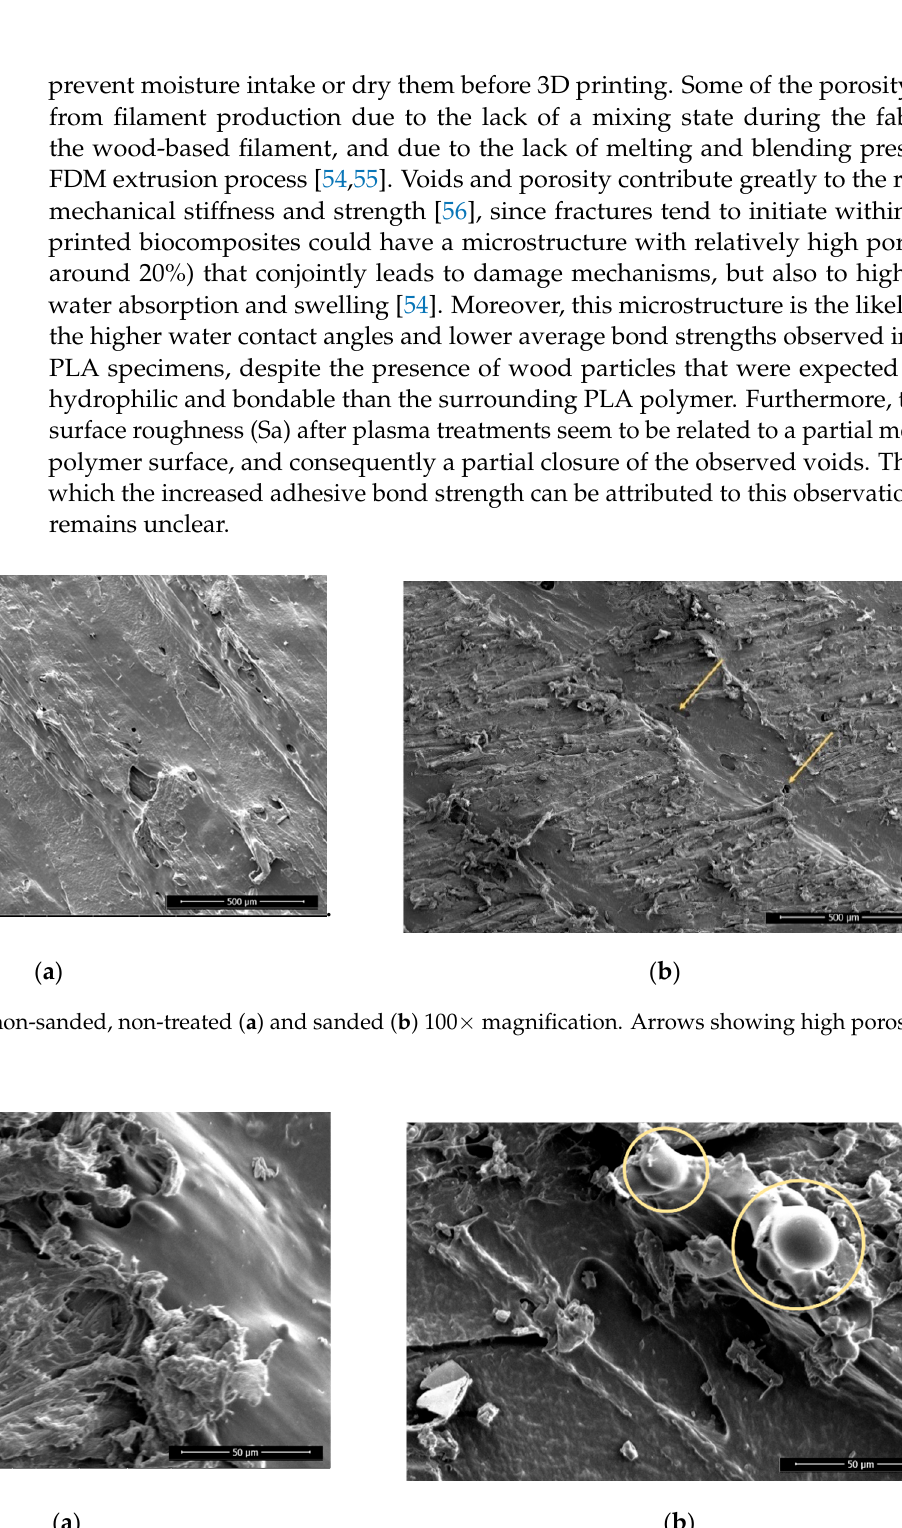
Table 1. Average surface roughness parameters S a and S dr measured on samples from acryloni- trile-butadiene-styrene (ABS), polylactic acid (PLA) and Wood-PLA, non-sanded (NS) and sanded (S) surface, non-treated (NP) and treated with plasma (P). .